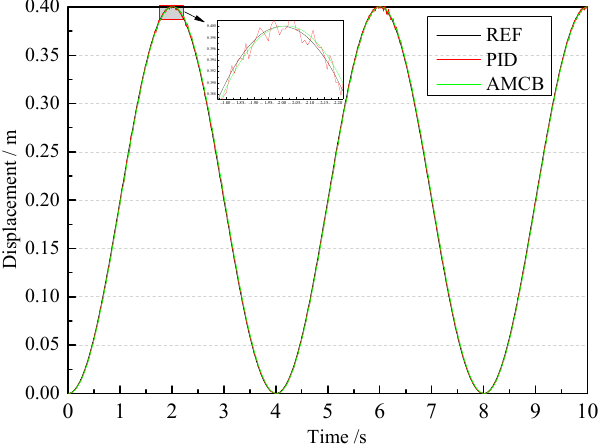
Figure 7. Displacement response curves of hydraulic cylinder.